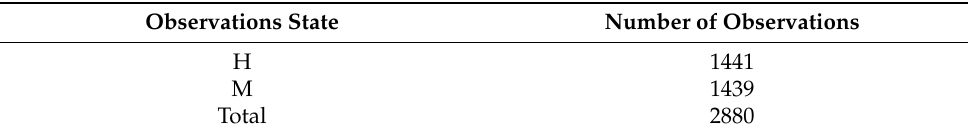
Table 3. Observation in the working database.